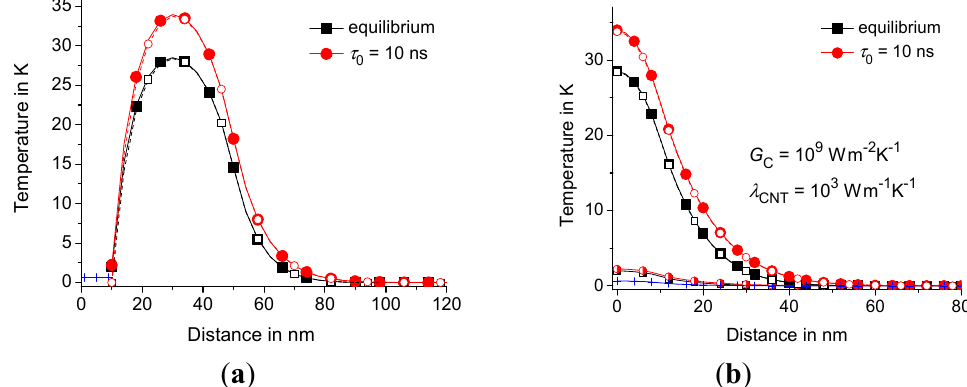
Figure 6. Temperature distribution T ( t , r , z ) vs. r ( a ) and T ( t , R C /2, z ) vs. z ( b ) are represented by the filled symbols, T CNT ( t , z ) is represented by the crosses, and T ( t , R 1 , z ) is represented by the semi-filled symbols at G C = 10 9 W · m − 2 K and λ CNT = 10 3 W · m − 1 K . The solution obtained in Section 4 for T ( t , R 1 , z ) = 0 is represented by open symbols. The equilibrium and nonequilibrium solutions ( τ 0 = 10 ns) are represented by squares and circles, respectively; t = 1 ns, τ p = 2 ns, R C = 50 nm, L C = 10 nm, R 1 = 10 nm, R 2 = 300 nm, and L z = 100 nm.